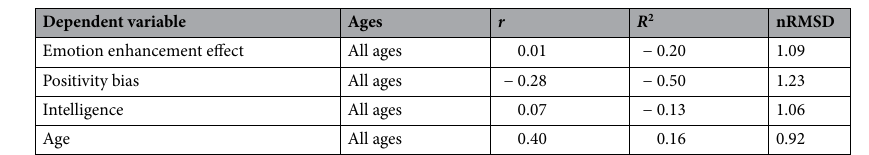
Table 7. Prediction results when including all edges (N = 258 participants). For all analyses, all nodes were included. Forty-five participants were excluded due to missing data in one or more nodes. For all analyses, we used Elastic Net, with ridge-lasso ratio = 0.01. The models were trained using leave-one-out